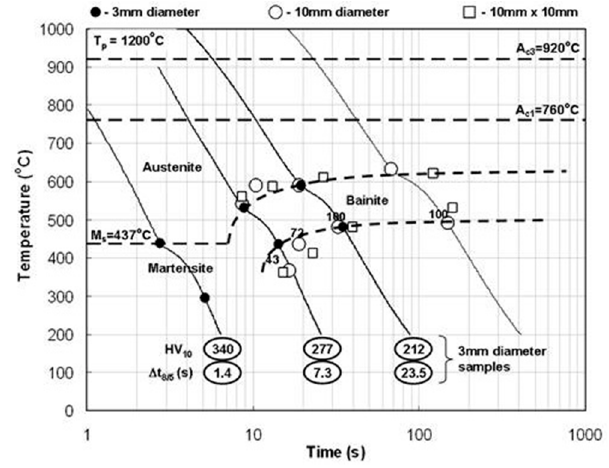
Figure 17. CCT (continuous cooling transformation) diagram for X70 steel [69].